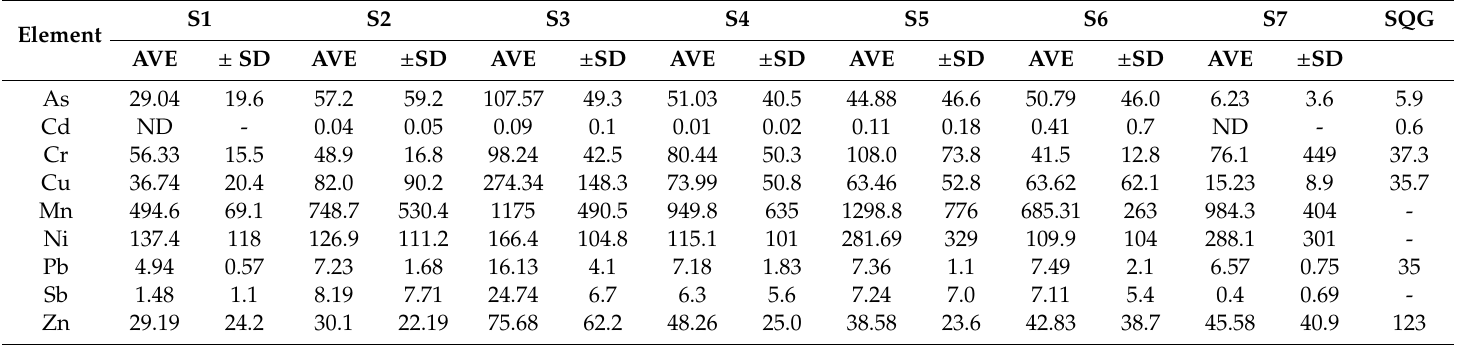
Table 2. Concentrations (mg kg − 1 ) of chemical elements at di ff erent sites in the Blyde River sediment